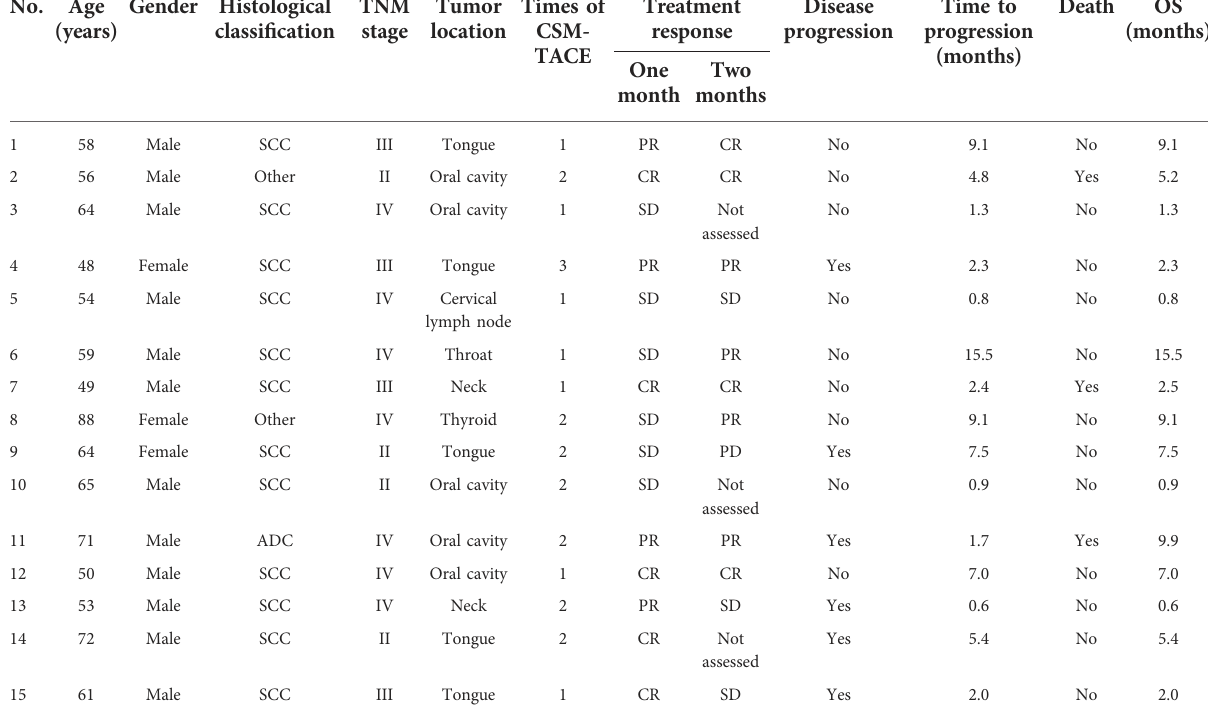
TABLE 4 Key characteristics and treatment outcomes of each